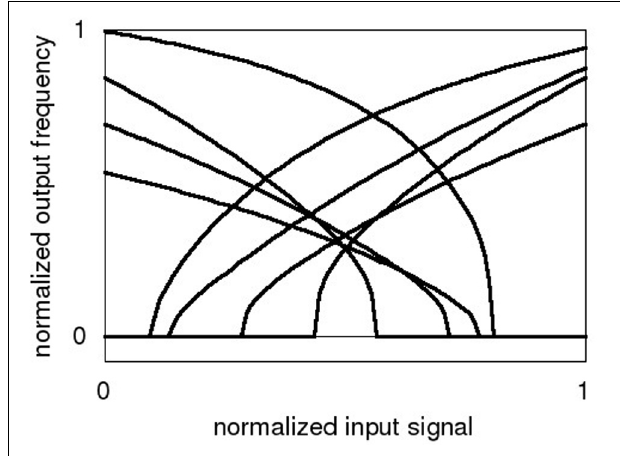
FIGURE 1 | Sample tuning curves for neurons in the NEF framework, normalized input signal (cid:2) x and normalized output frequency a i